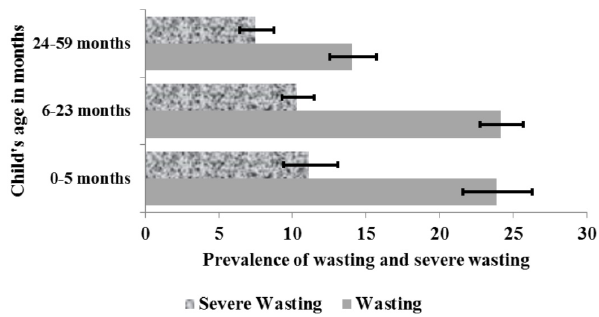
Figure 2. Prevalence of wasting and severe wasting by child’s age in months.